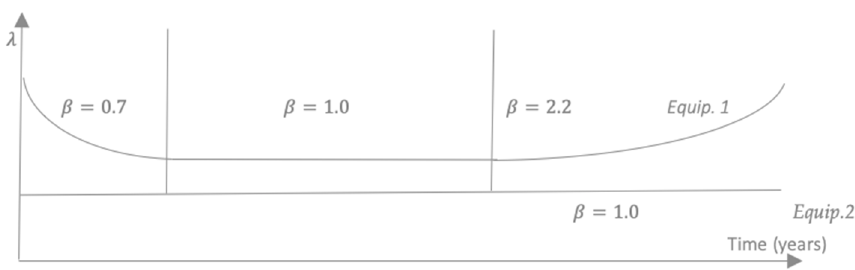
Figure 2. Projected Failure rate for both physical assets.